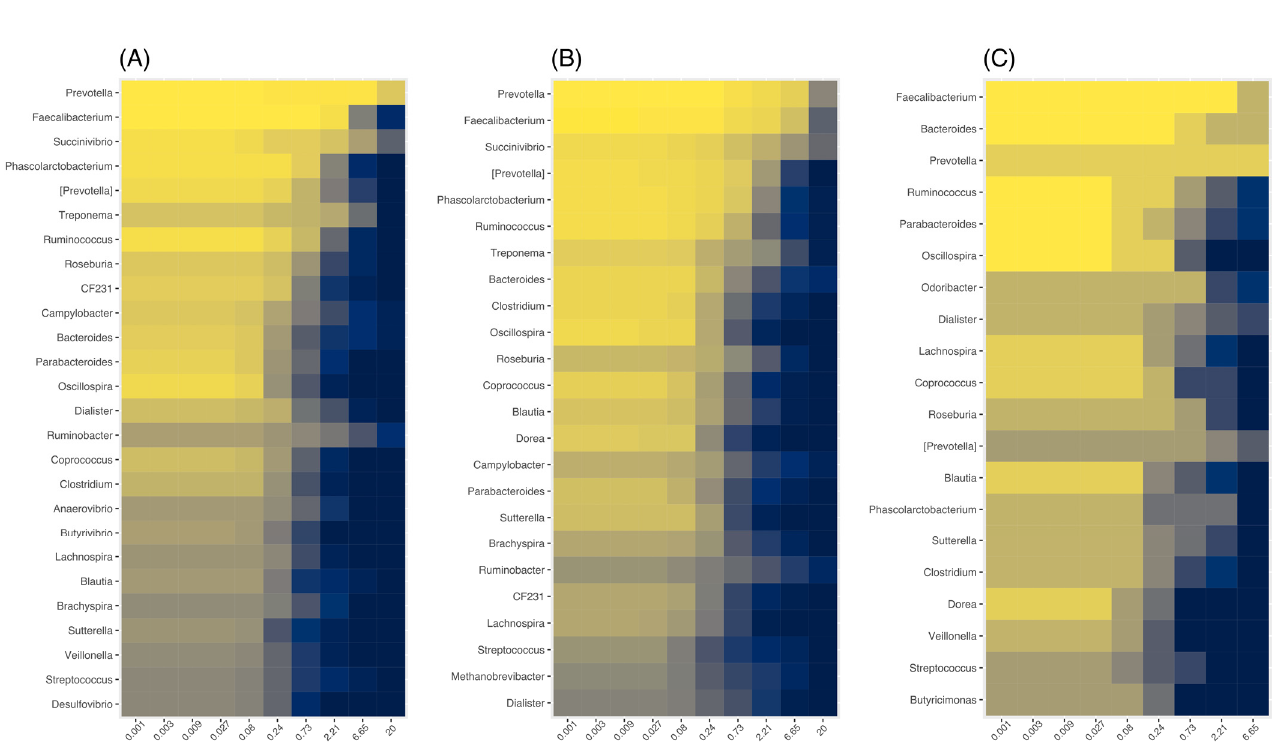
Figure 2. Core microbiomes by location: ( A ) Siminke; ( B ) Tezumake; ( C ) Valledupar. The x-axis indicates the detection threshold in relative abundances.